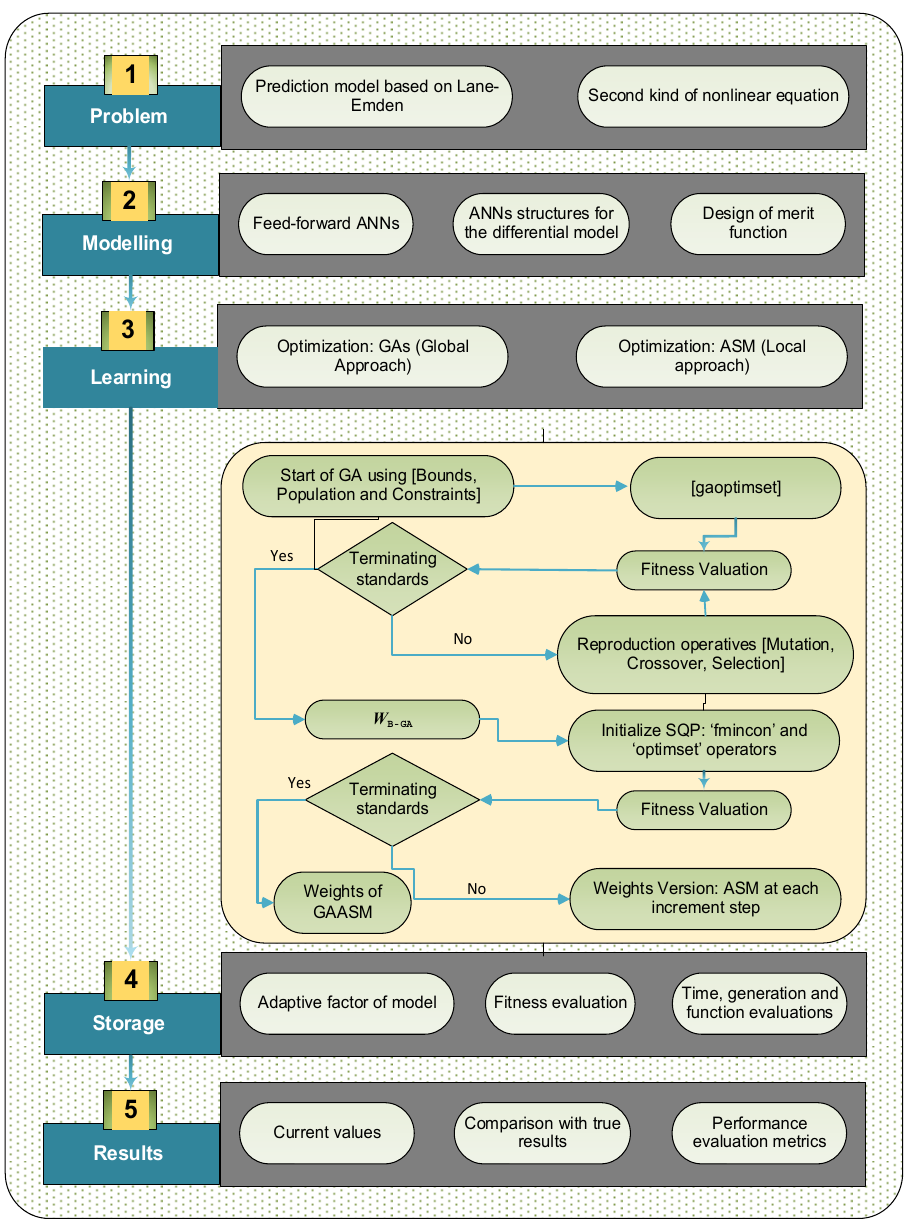
Figure 1. Workflow diagram of the proposed ANN-GAASM for solving the second kind of NLE-PDSM .